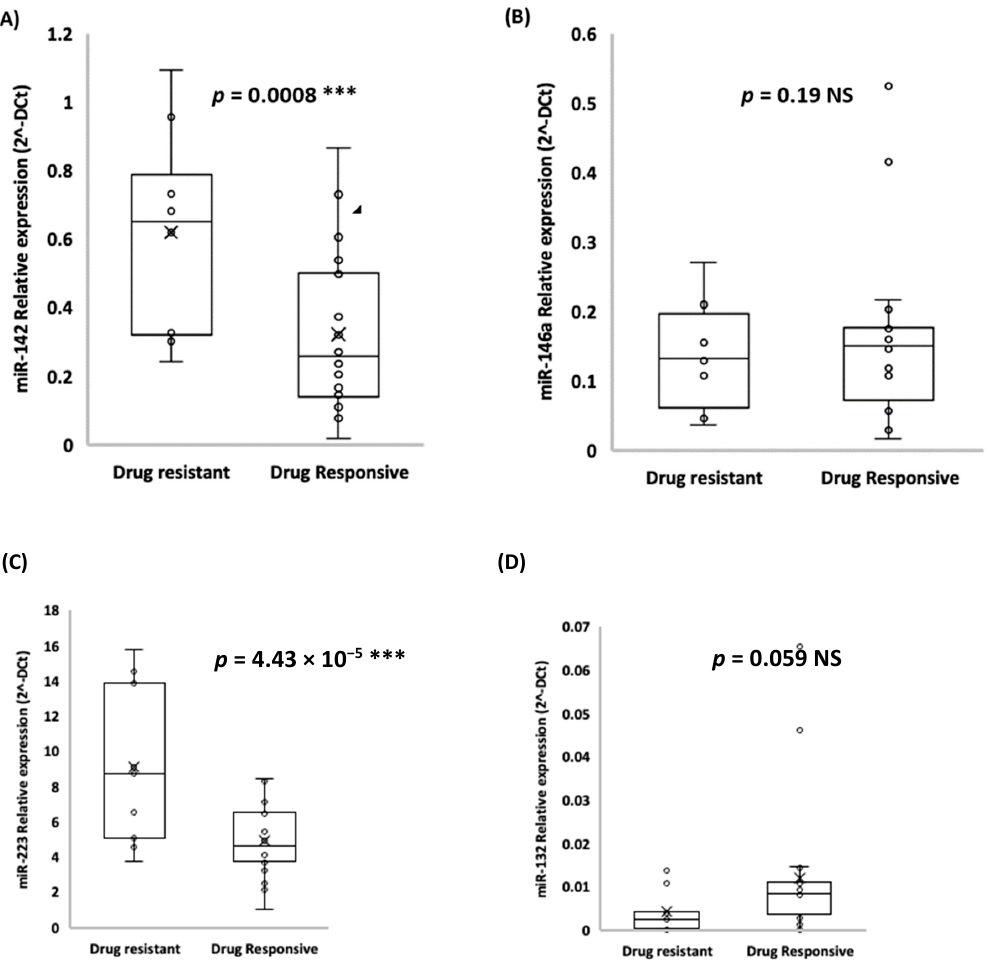
Figure 2. miR-142 ( A ), miR-146a ( B ), miR-223 ( C ), and miR-132 ( D ) relative expression (average expression ± SD) in drug-sensitive versus drug-resistant TLE patients ( t -test, *** p -value <